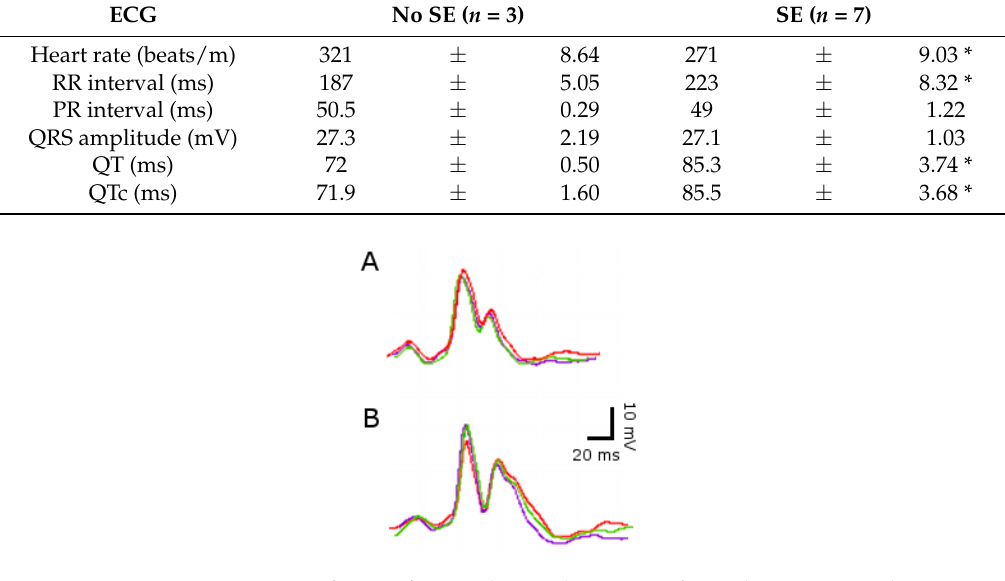
Figure 2. Representative traces of ECG after single SE. Three traces for each experimental group are shown. ( A ) ECG of the control group (No SE). ( B ) ECG of the convulsive group (SE). Note the elongated QT time in ( B ).